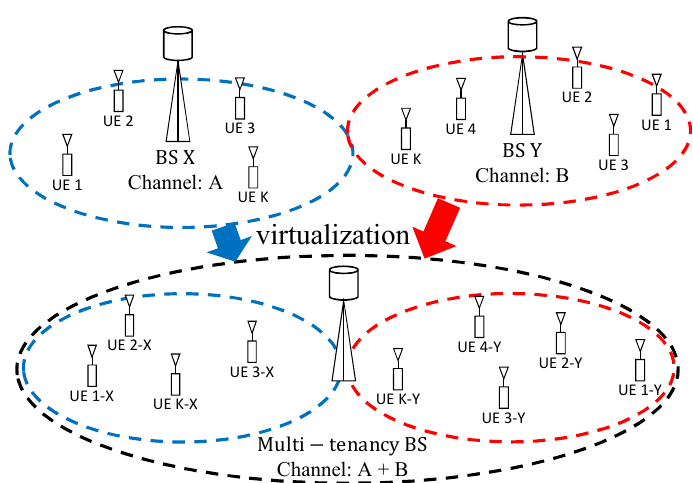
Figure 1. One exemplary use case for RF front-end virtualization: A single BS that emulates multiple virtual BSs. Here, subscribers from different networks associate with their corresponding virtual BS by using the same underlying